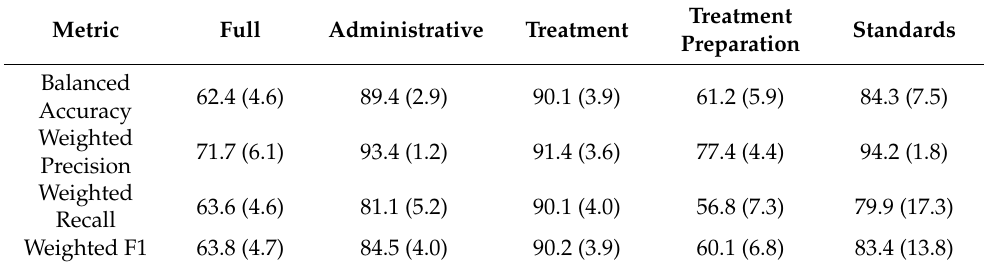
Table 4. Model performance on test data with tf-idf + LSA +